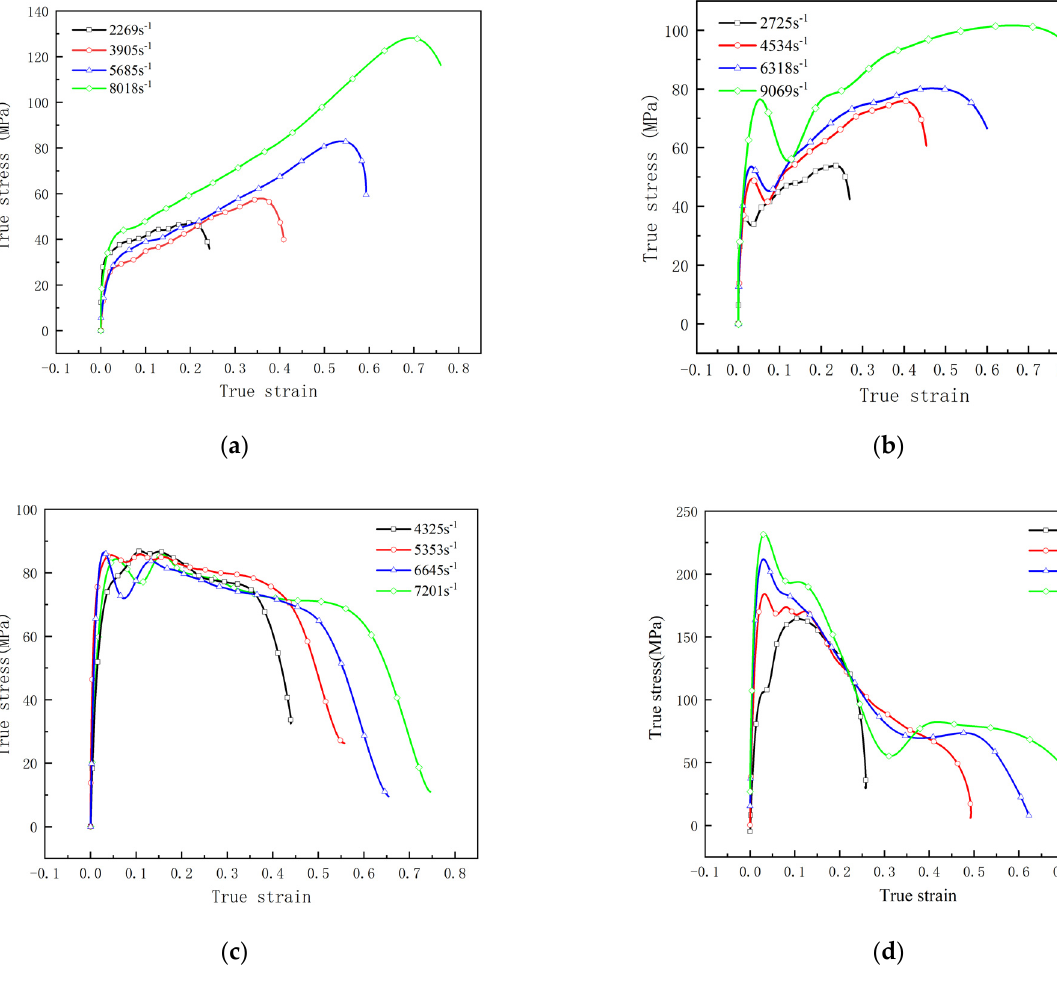
Figure 7. Dynamic compressive curves of RMs: ( a ) 26.5% Al/73.5% PTFE ( b ) 5.29% Al/80% W/14.71% PTFE ( c ) 62% Hf/38% THV ( d ) 88% Hf/12% THV. W/14.71% PTFE ( c ) 62% Hf/38% THV ( d ) 88% Hf/12%